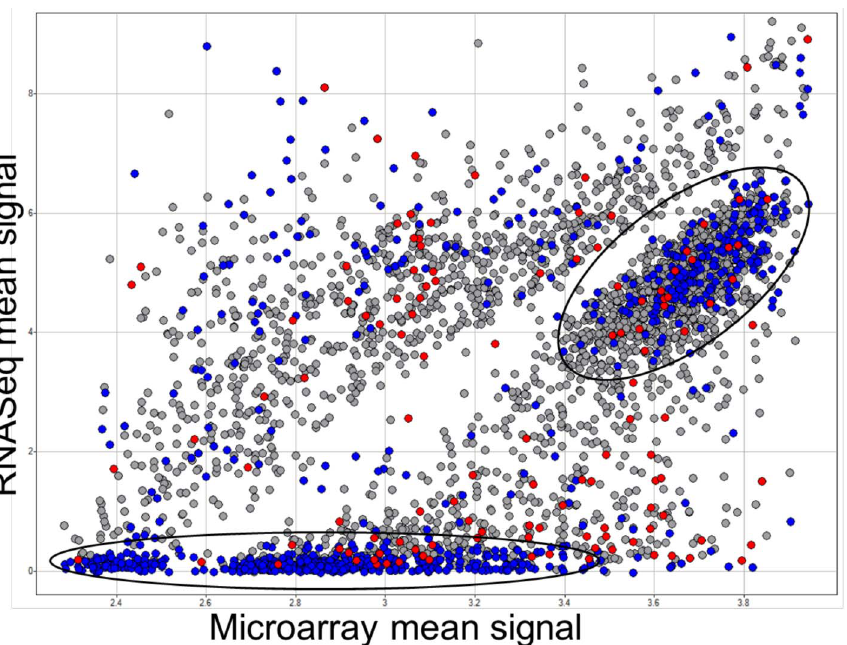
Figure 6. Comparison of expression profiles for individual genes in RNA-Seq and microarray co-expression networks based on expression conservation. The 3,354 genes with significant differences (p , 0.01) in expression conservation between RNA-Seq and microarray data were assessed. The mean expression level in microarray samples (x-axis; log 2 tranformed) and RNA-Seq samples (y-axis; inverse hyperbolic sine transformed) was compared. The color coding indicates connectivity in the two co-expression networks; red indicates the 122 genes with more connections in the microarray network, blue indicates the 796 genes with more connections in the RNA-Seq co-expression network and grey indicates relatively similar connectivity in both networks. The circles indicate two clusters of genes with divergent EC scores.